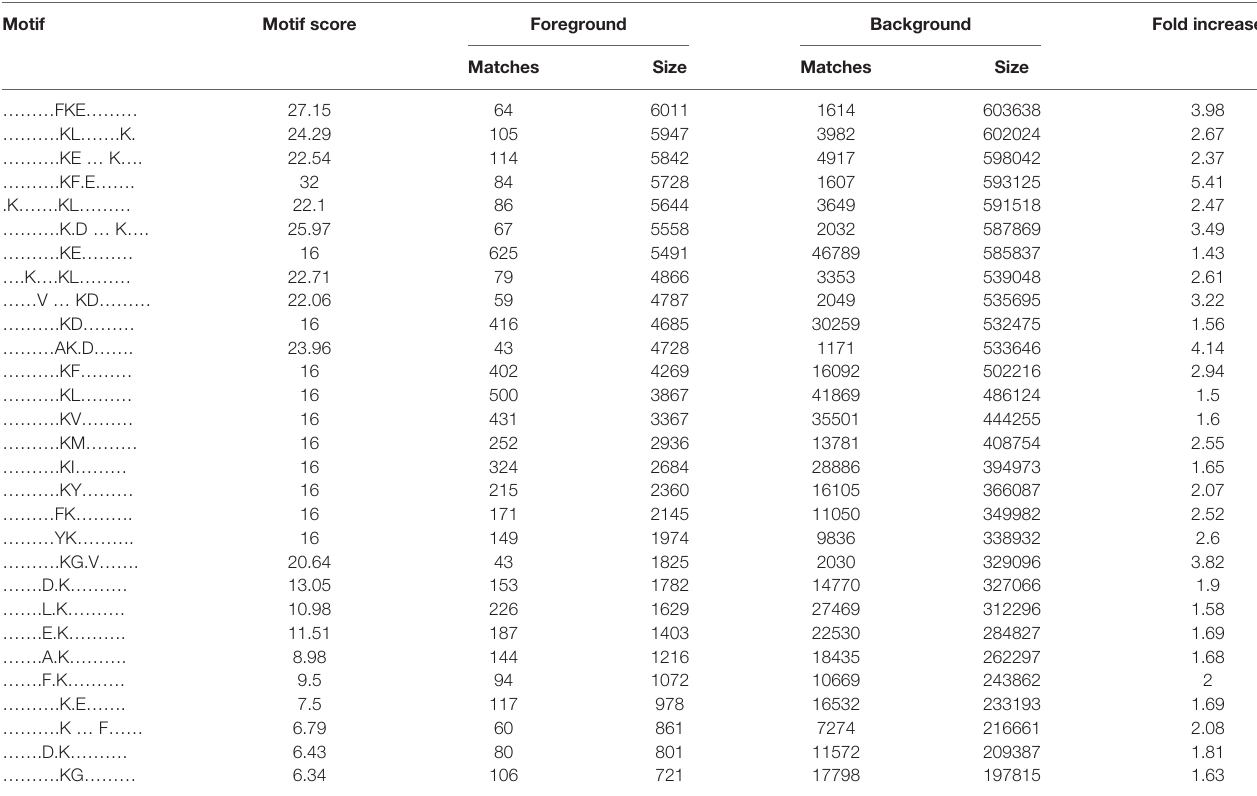
TABLE 2 | Crotonylated lysine motifs in HEK-293T cells transfected with BspF. Motif Motif score Foreground